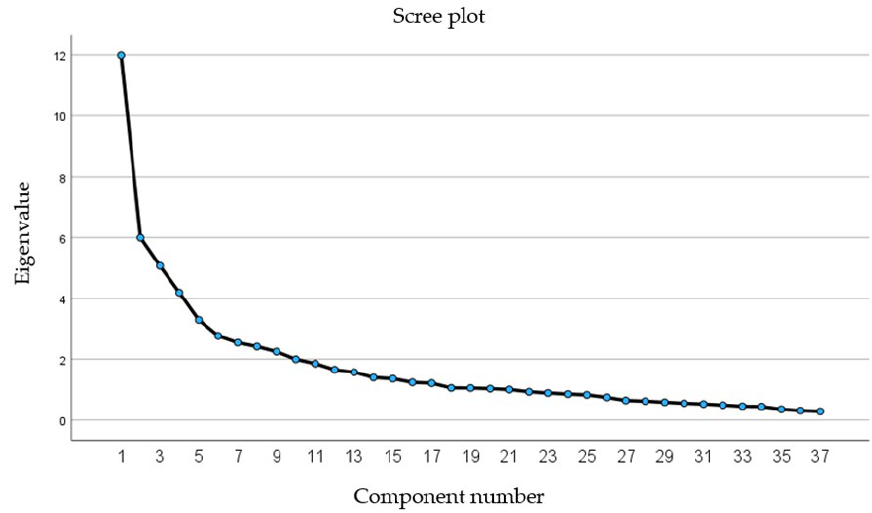
Figure A1. PCA scree plot. Table A1. Esports players dietary habits—percentage response distribution.